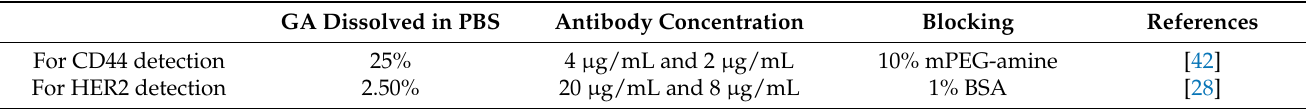
Table 1. Conditions used to functionalize